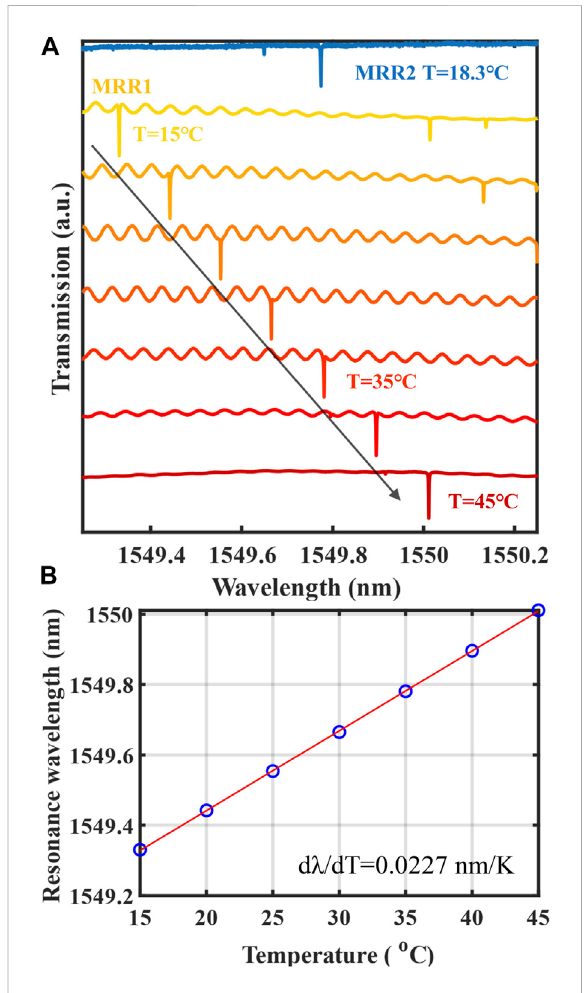
FIGURE 2 (A) Transmission of the two different soliton modes at low power and different temperatures. (B) Dependence of the resonance wavelength on the chip temperature and a linear fi